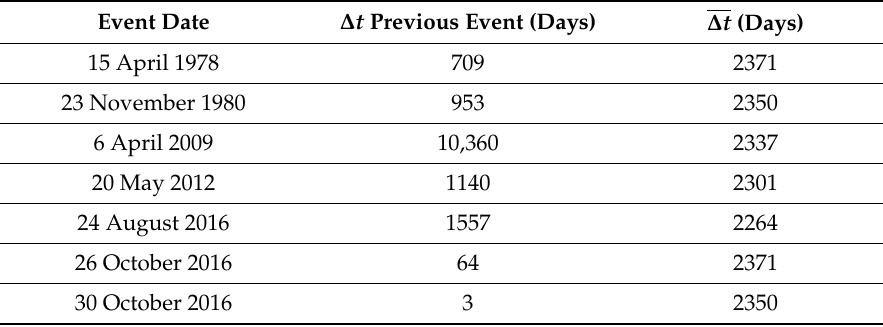
Table 1. Date of occurrence of the seven last major events in Italy. The other columns are ∆ t with respect to the previous event and the average ∆ t from 1600 up to the current event, both in